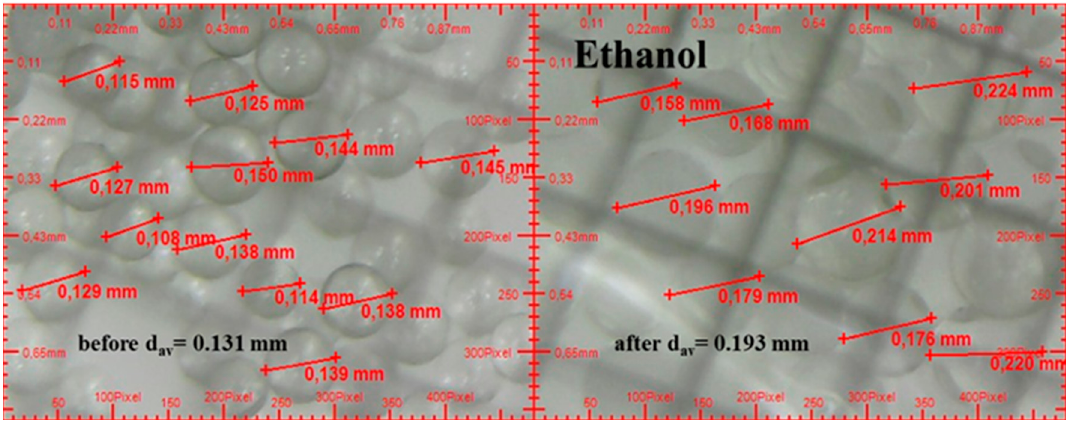
Figure 1. Optical microscopic image of TNSH 2 swelling in ethanolbefore and after swelling in ethanol.